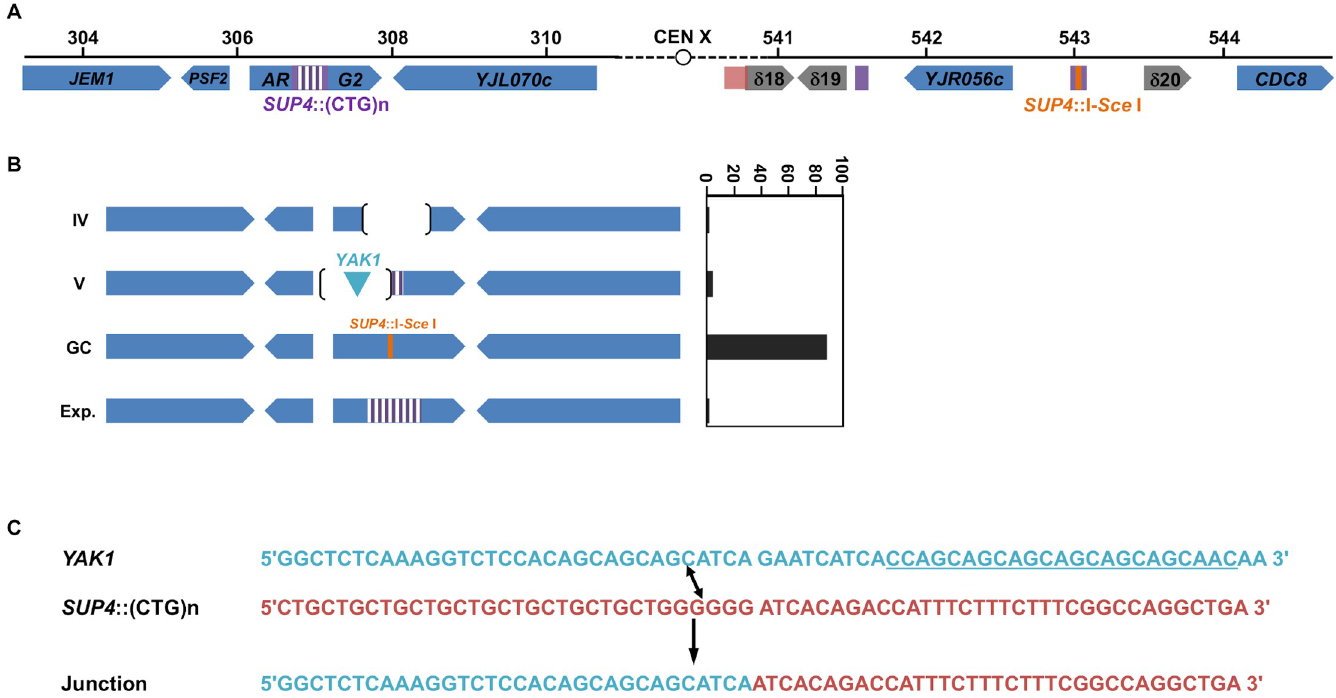
Fig 6. Chromosomal rearrangements observed at the ARG2 locus, following Sp Cas9 induction. A : ARG2 and SUP4 loci drawn to scale. A 2.6 kb piece of DNA containing 1.8 kb of the SUP4 locus in which a CTG repeat was integrated, as well as the TRP1 selection marker were integrated at ARG2 [31]. The TRP1 gene is not represented here but is centromere-proximal located. B : Types of rearrangements observed. Types IV and V deletions are explained in Fig 5. GC: gene conversion with SUP4 ::I-SceI. Exp.: CTG repeat expansion. C : Type V rearrangements involving the YAK1 gene. The off-target in YAK1 identified by CRISPOR is underlined. The blue sequence from YAK1 recombined with the red sequence from SUP4 to give a hybrid molecule called "Junction".